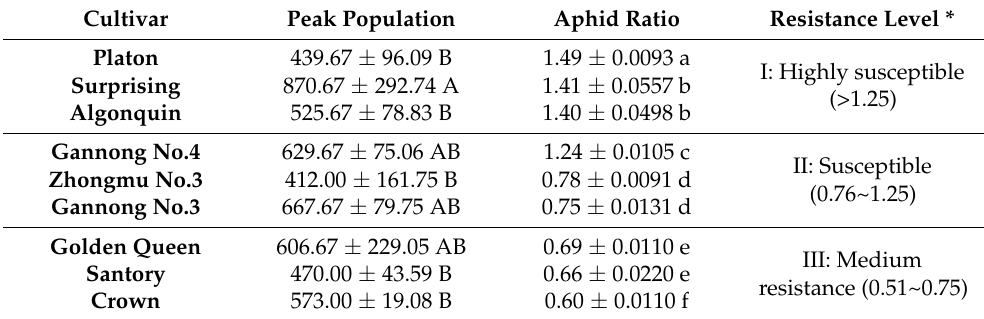
Table 2. Alfalfa cultivars and three population parameters of the pea aphid, Acyrthosiphon pisum , from a biological control field study in Ningxia Region, China, in